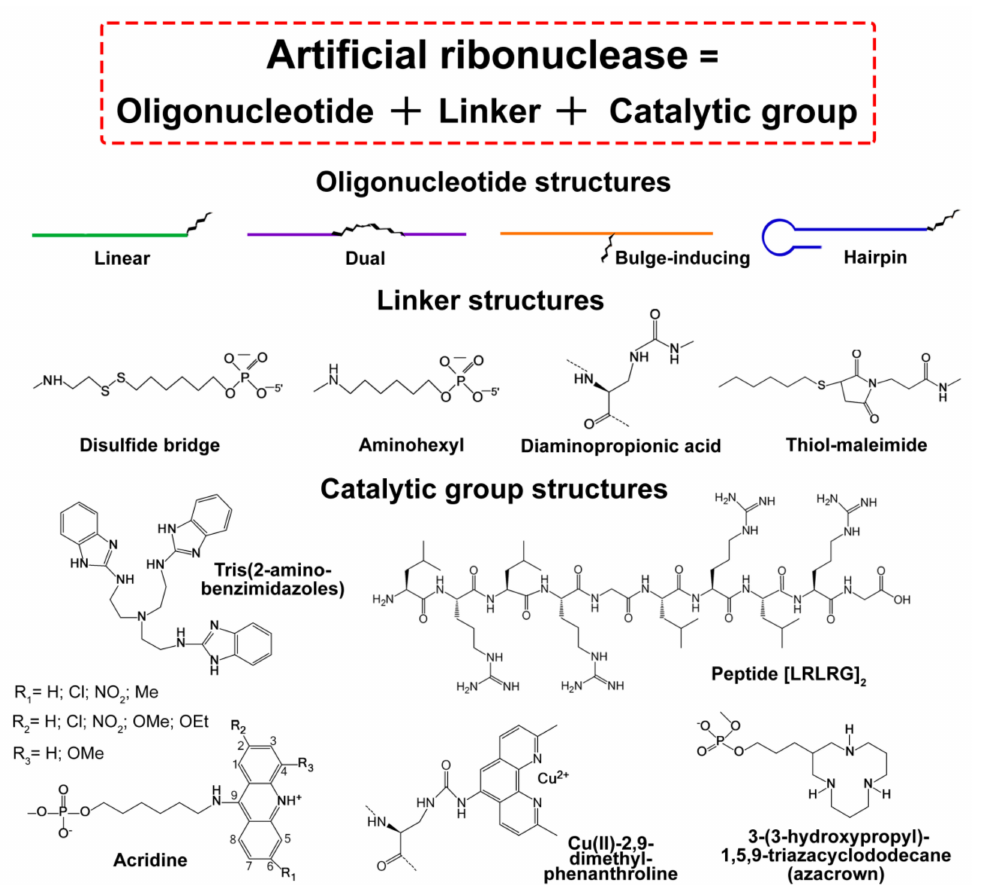
Figure 1. General design concept of currently established ss-aRNase, summarising the key structural features of the oligonucleotide recognition motifs (top), linkers (middle) and catalytic domains